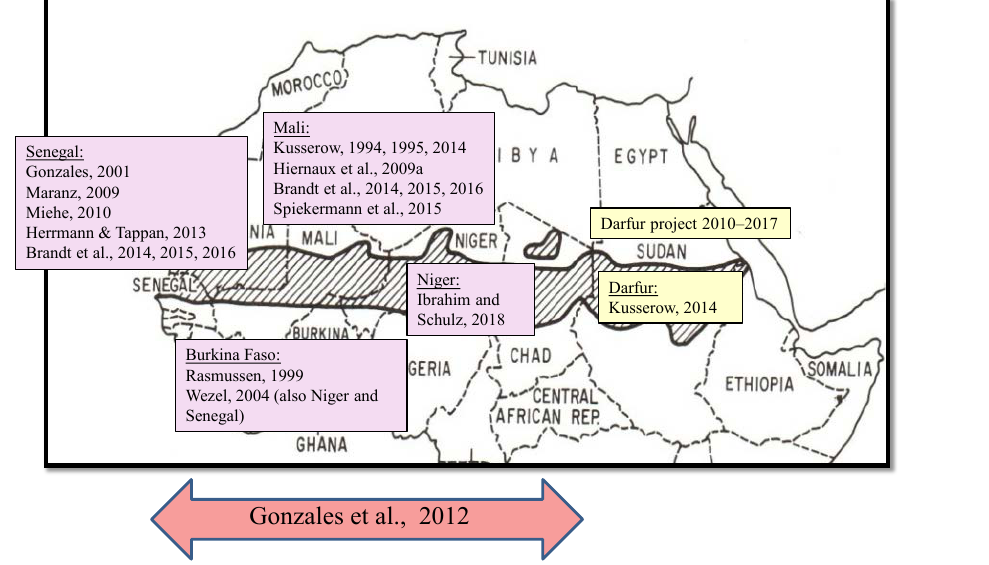
Figure 18. Shift from pre-drought mesic to post-drought xeric plant species according to author and region.